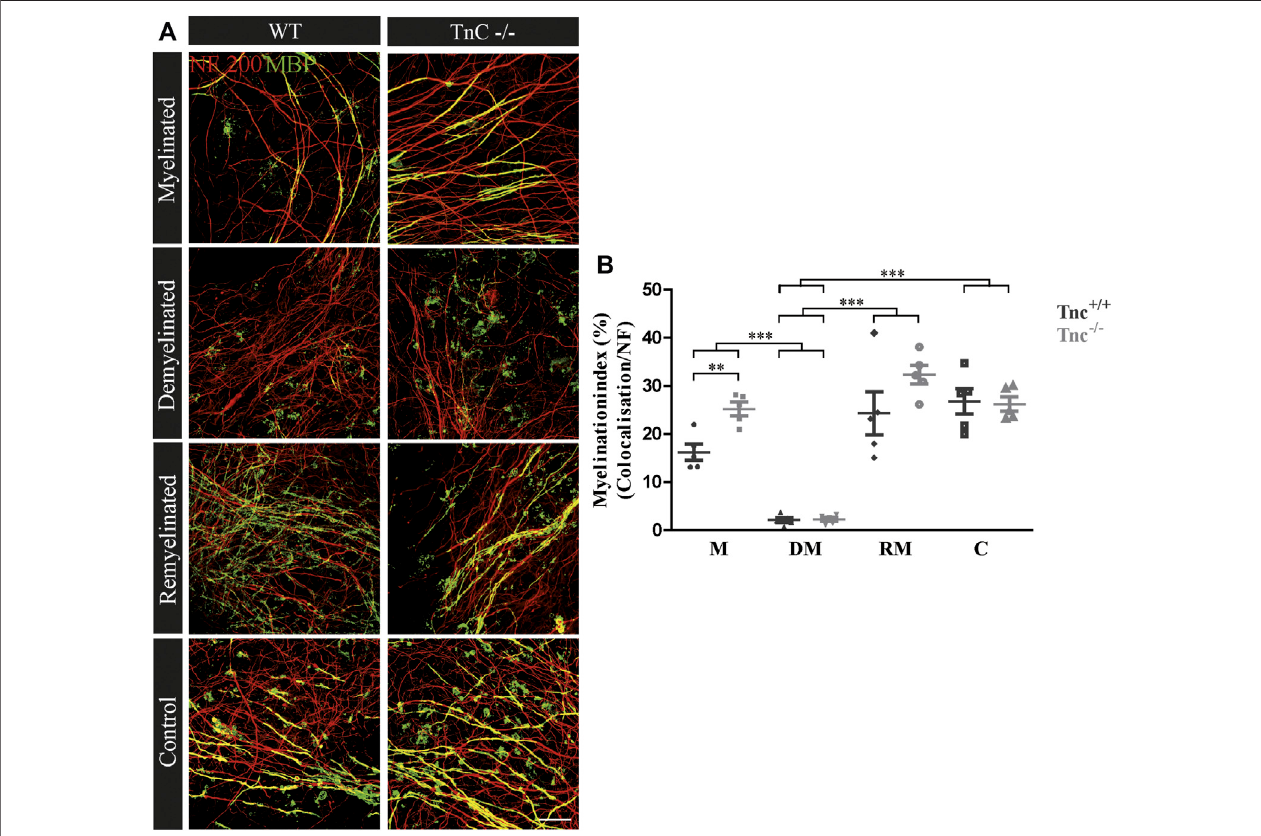
FIGURE2|(A,B) Comparisonofmyelinationandremyelinationinlivecerebellarexplantculturesof Tnc +/+ and Tnc − / − mice. (A) Tnc +/+ and Tnc − / − cerebellarexplant cultures of the conditions myelinated (M), demyelinated (DM), remyelinated (RM), and control (C) were labeled with antibodies against NF200 (red) and MBP (green) to visualize the wrapping of myelin membranes around nerve fi bers. Colocalization ofneuro fi lament and MBP appeared as yellow staining. Demyelination nearly eliminated MBP-labeling. The myelinated condition shows a highly distinctive MBP staining. An initiating remyelination is visible for both genotypes. (B) Quanti fi cation of myelination indices of each condition in the comparison of Tnc +/+ and Tnc − / − explant cultures (M, myelinated; DM, demyelinated; RM, remyelinated; C, control). For the demyelinated condition, the quanti fi cation shows a signi fi cant reduction of the myelination index compared to the other conditions. Overall, both myelination and remyelination appeared more extensive in the absence of Tnc. All data are provided as mean ± SEM. Statistical signi fi cance was assessed using the two-way ANOVA (* p ≤ 0.05,** p ≤ 0.01,*** p ≤ 0.001)andTukey ’ smultiple-comparisonstest.Scalebars:20 µm.Sixindependentexperiments(N=6)wereperformed,andthreeexplants ( n = 3) were analyzed per experiment for each